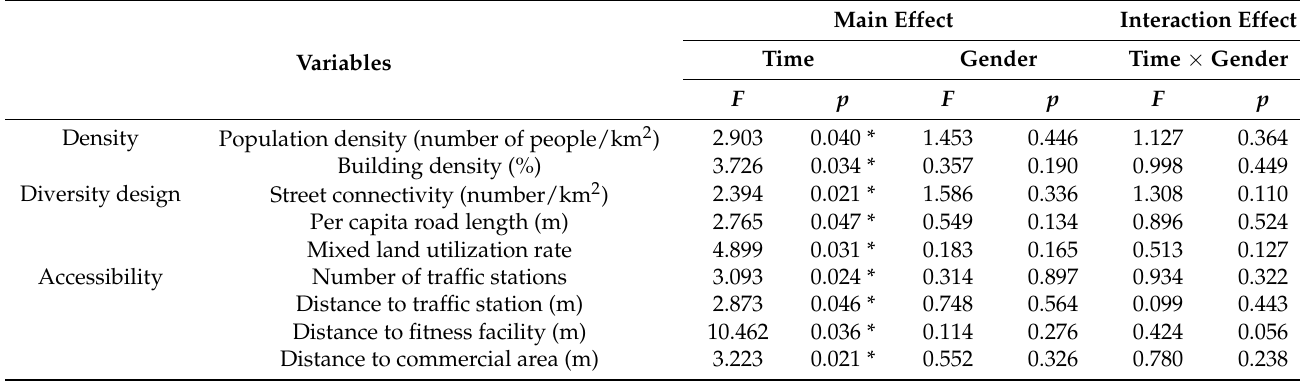
Table 3. ANOVA of time, gender, and built environment variables.